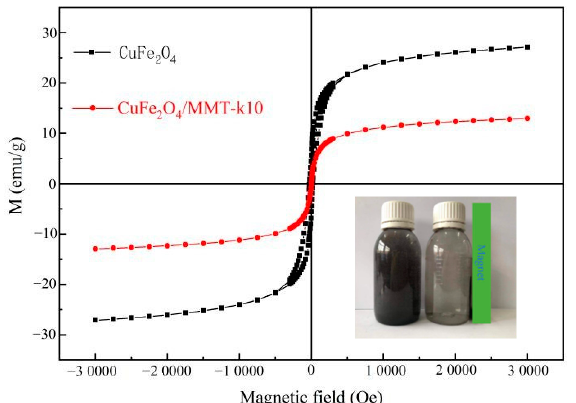
Figure 4. Magnetic hysteresis loops of CuFe 2 O 4 and CuFe 2 O 4 /MMT-k10, as well as a magnetic recovery diagram (inset).